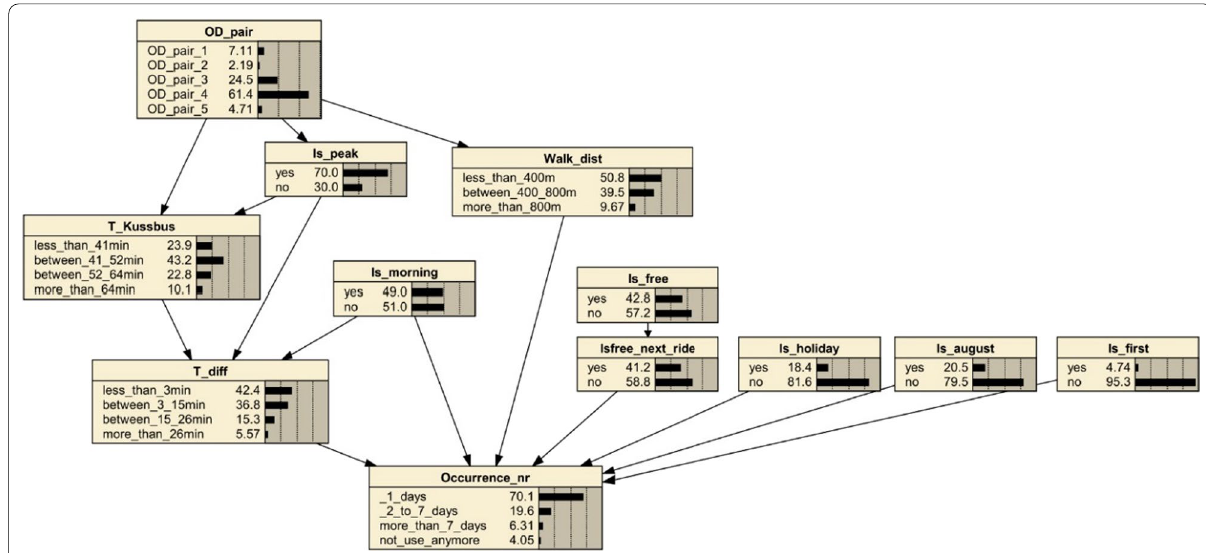
Fig. 6 Learned BN structure for Kussbus user next ride occurrence